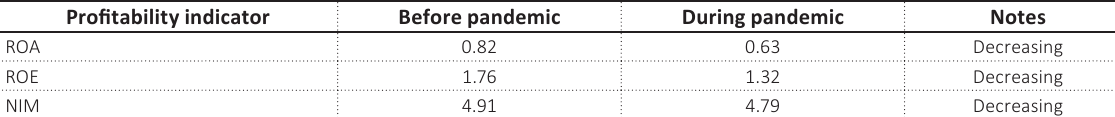
Table 1. Indonesian banking profitability before and during the COVID-19 pandemic Profitability indicator Before pandemic During